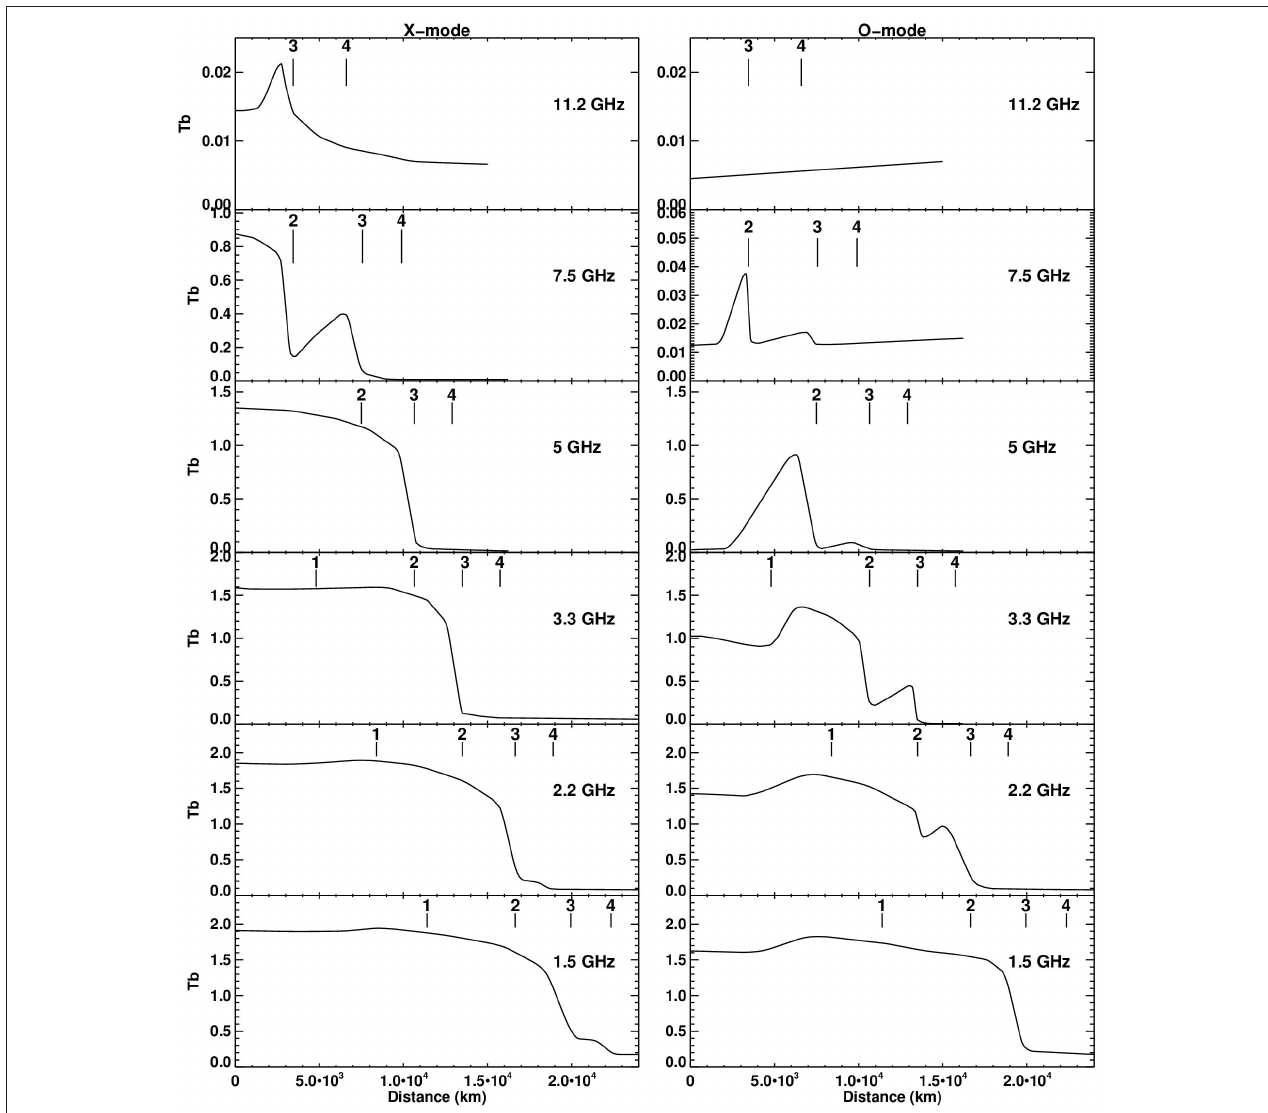
FIGURE 7 | Brightness temperature (in units of million degrees Kelvin) of the x -mode (left) and o -mode (right) emission as a function of distance from the center of a dipole sunspot model at several frequencies (see text for details). The position at which the harmonic layers cross the base of the TR are marked with vertical straight